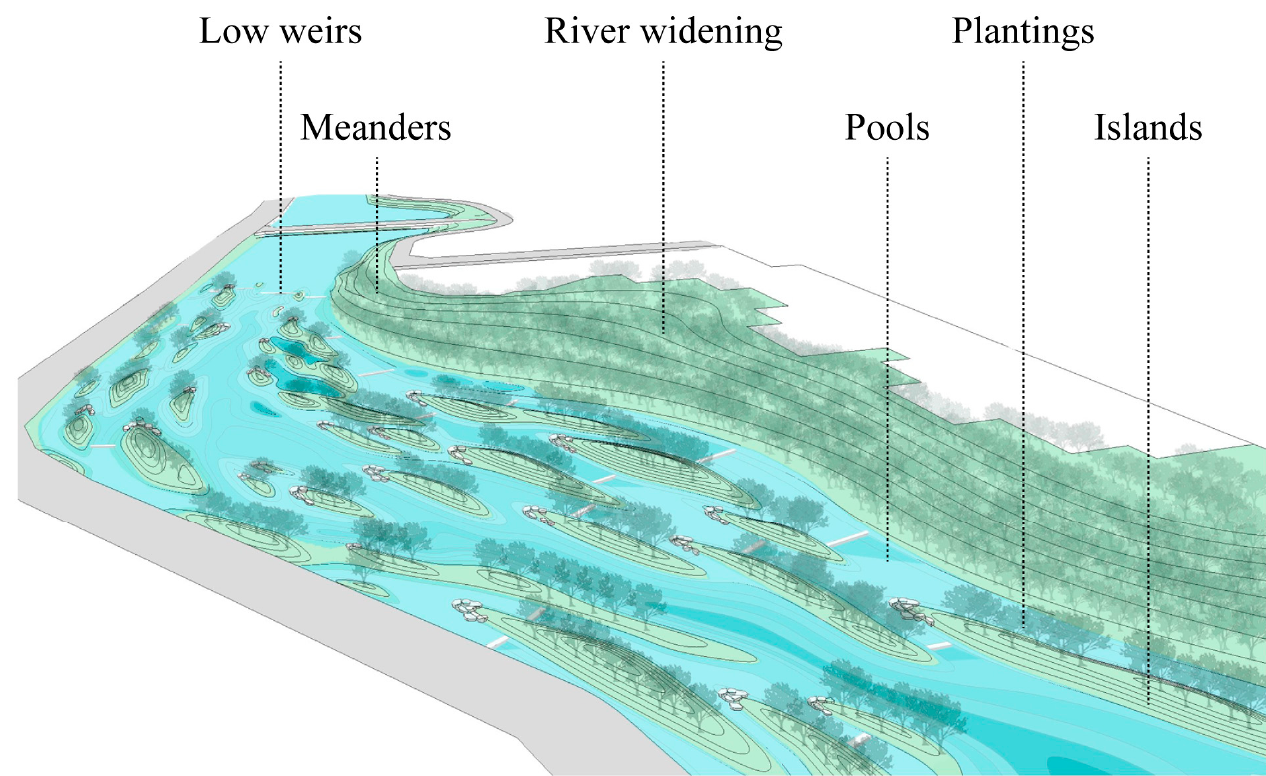
Figure 3. Flow strategies include building low weirs to slow the water without breaking the river continuum, widening the river and reintroducing meanders, constructing diverse landforms such as islands and pools, stabilizing landforms with plantings, and so on.